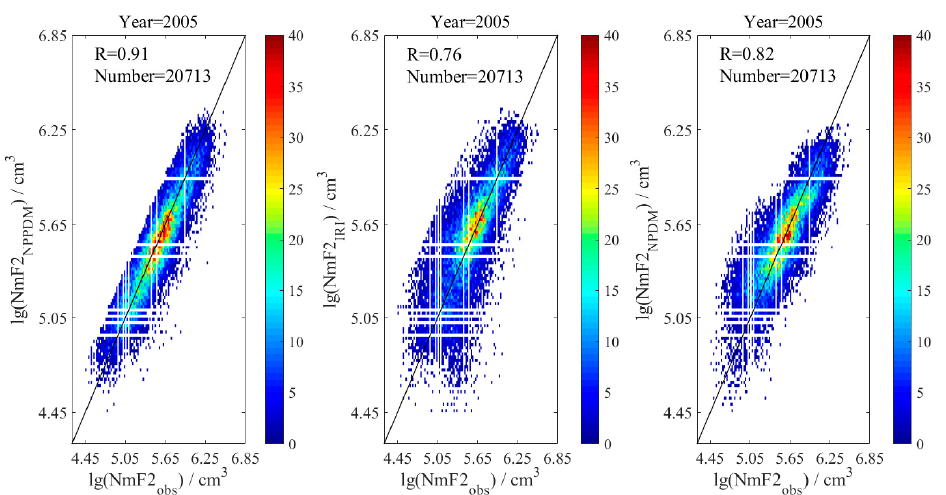
Figure 4. Data density of NPPDM (left), IRI2016 (middle), and NPDM (right) versus IRO NmF2 in 2005.